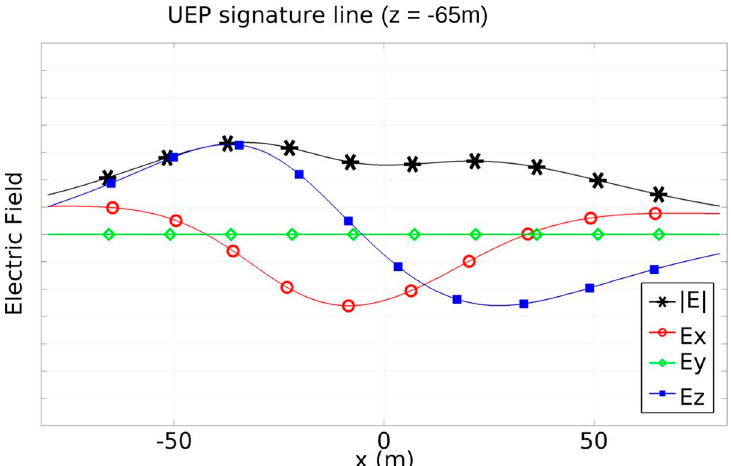
Figure 11. Numerically simulated UEP signature line for a submarine model. The fields were sampled along the sensor line in the x ‐ direction at a constant height of z u = − 65 m below the waterline (40 m below the keel of the submarine). The ordinate scale is the same as in Figure 12.